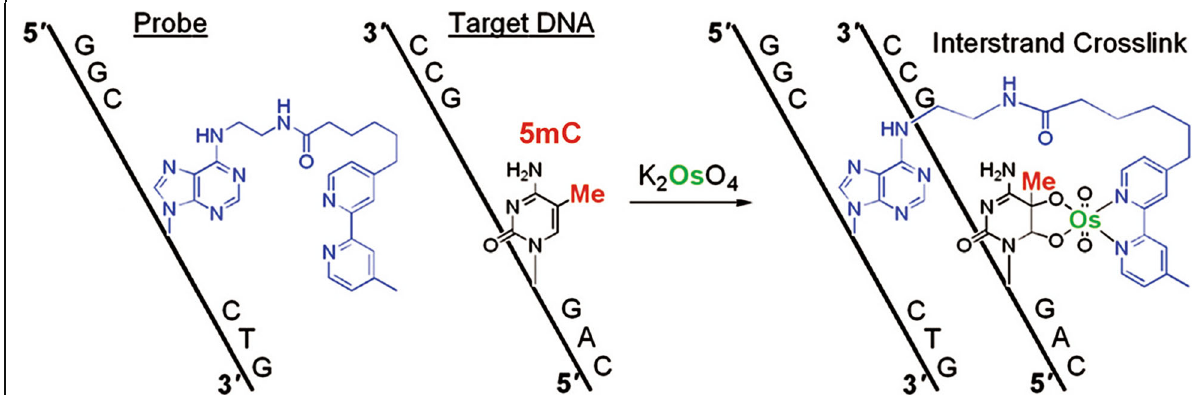
Fig. 4 Crosslinking of ICON probe with the target 5mC in DNA by osmium complex